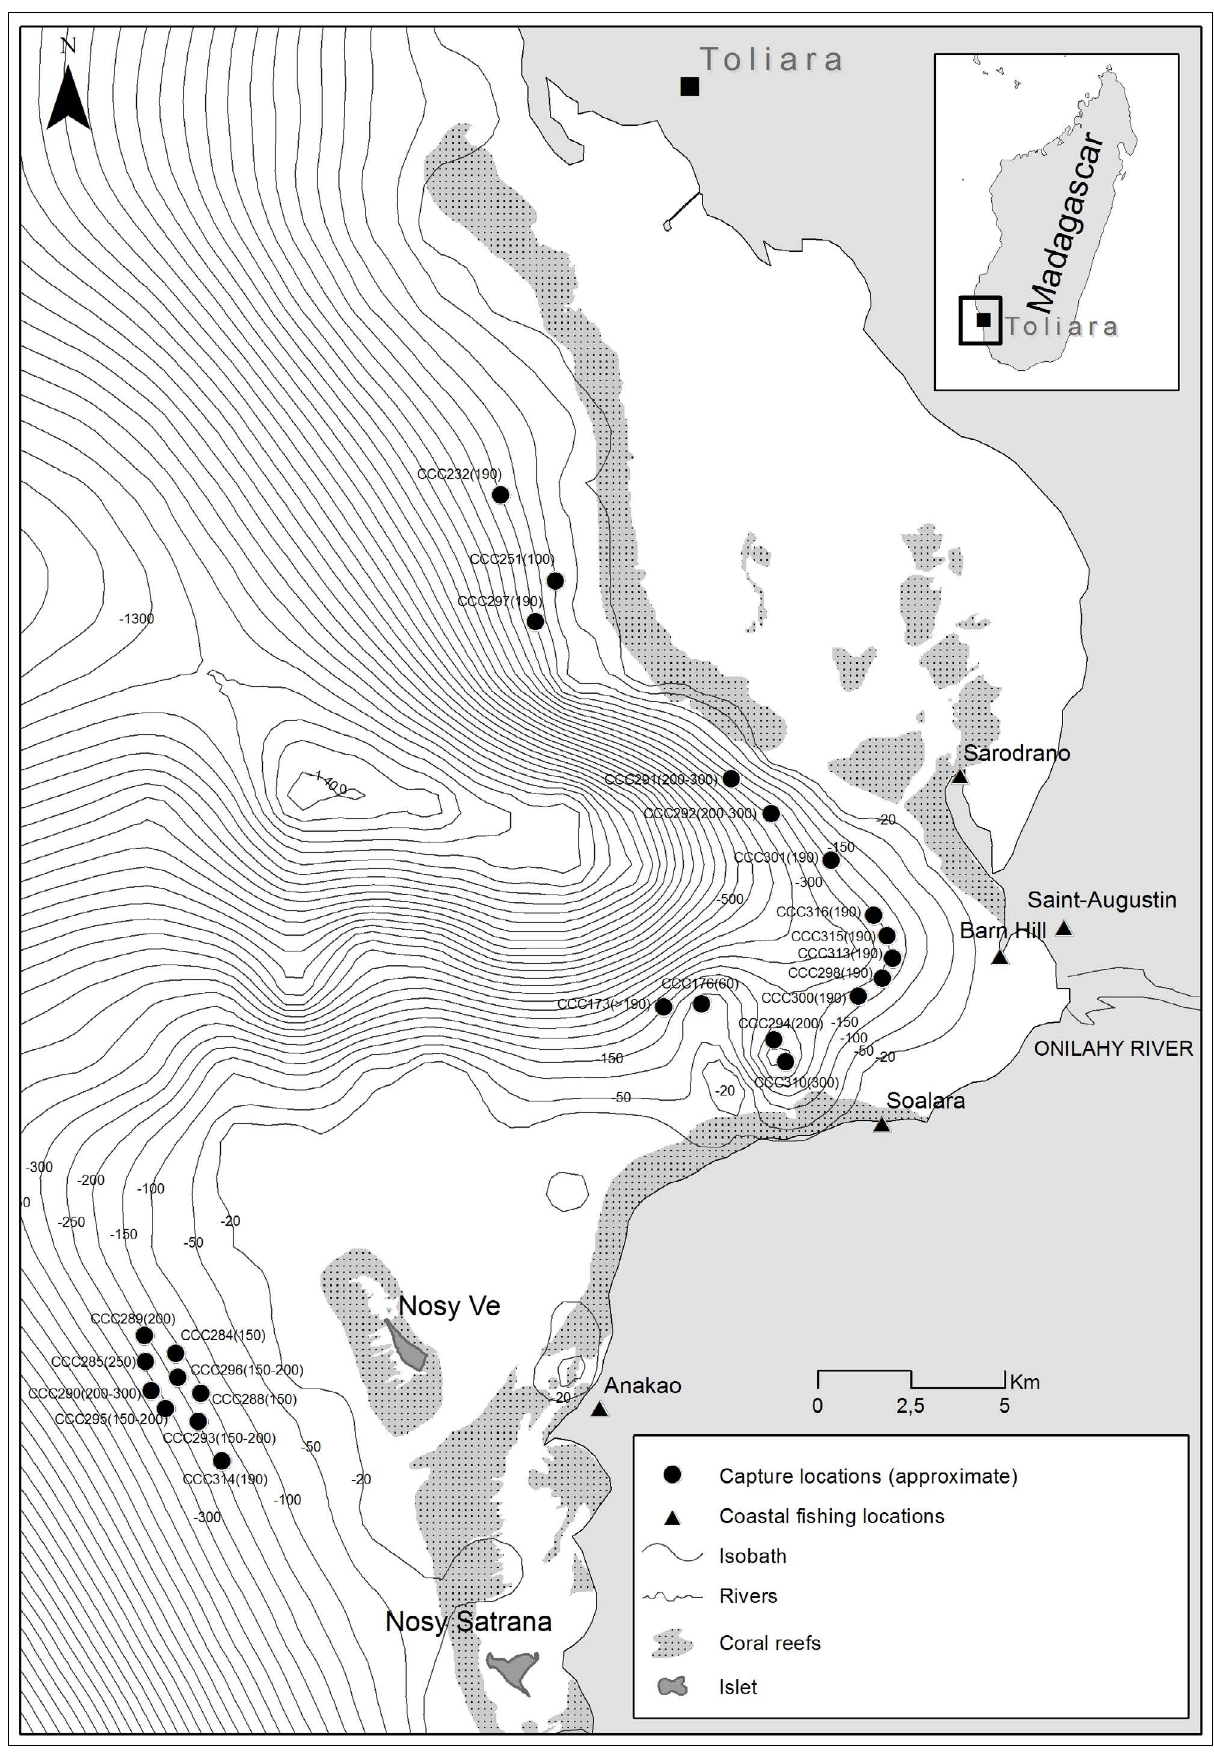
Figure 5: Map of St Augustin Bay, southwestern Madagascar showing the locations of the cluster of coelacanths caught from 1987 to 2019 near the Onilahy